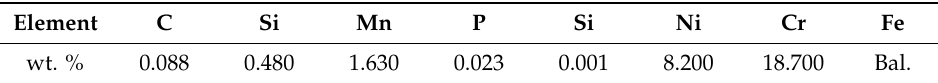
Table 1. Chemical composition of 304 stainless